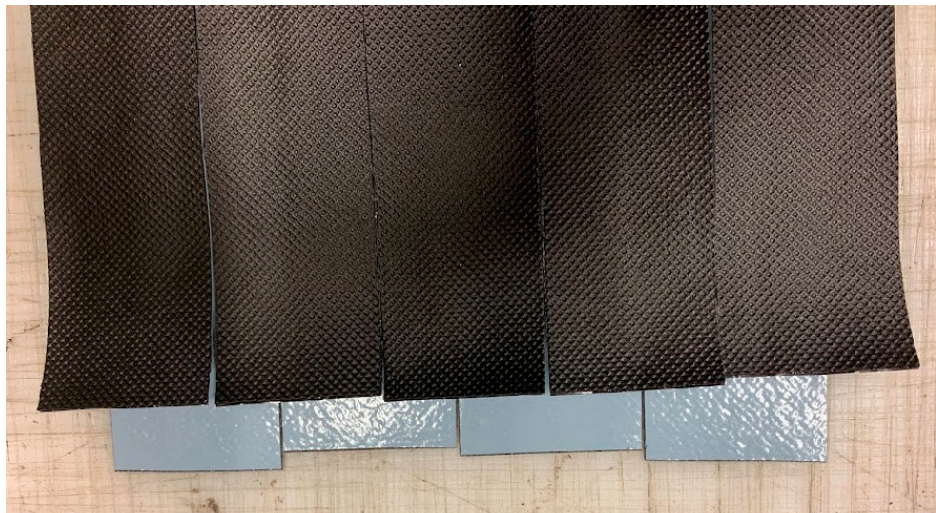
Figure 2. Visualisation of overlapping bands in a test sample. The picture was taken before the samples were glued together and circular samples of 174 mm were stamped out.